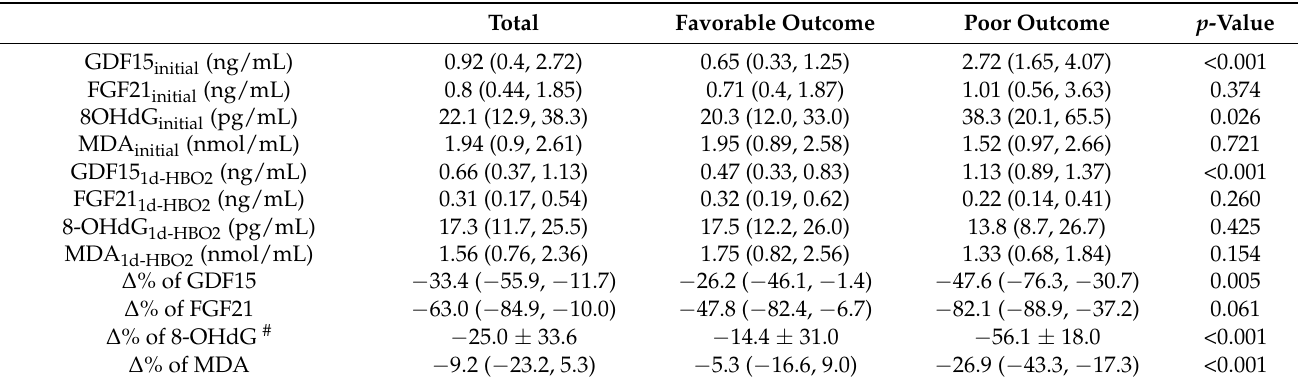
Data are presented as the median (interquartile range) or mean ± standard deviation. p -values were obtained using the Mann–Whitney U test or # independent t -test, as appropriate. Initial, serum biomarkers were measured at the time of arrival at the Emergency Department (0 h); 1d-HBO 2 , serum biomarkers were evaluated 24 h post HBO 2 therapy; GDF15, growth differentiation factor 15; FGF21, fibroblast growth factor 21; 8-OHdG, 8-Oxo-2 (cid:48) - deoxyguanosine; MDA, malondialdehyde. The change ( ∆ %) in each parameter was calculated as follows: (1 day post HBO 2 therapy value − initial value)/initial value test) ×